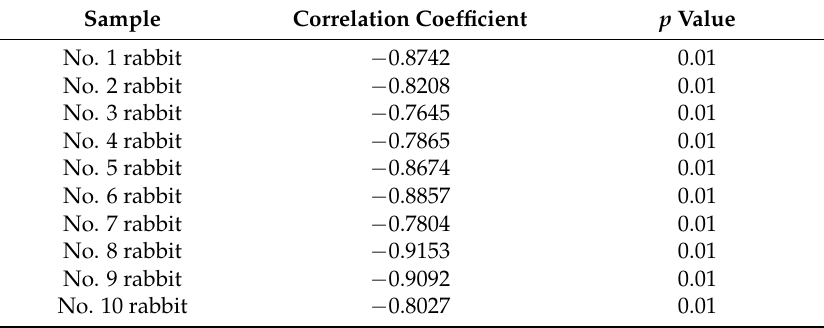
Table 3. Correlation analysis of ICP and MIPS from the experimental